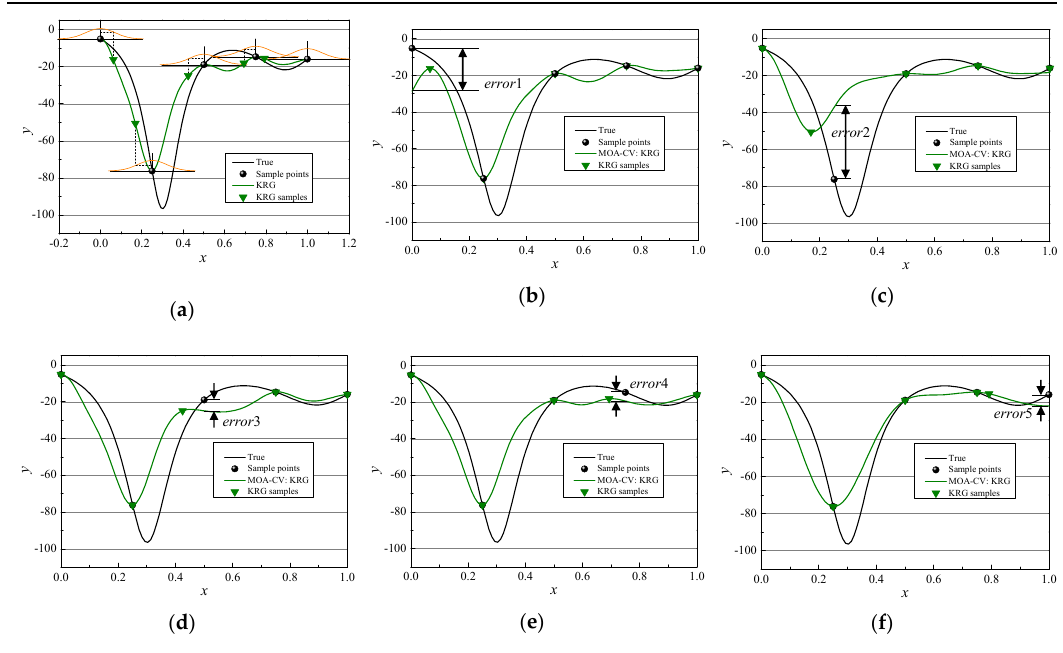
Figure 2. Demonstration of the move-one-away cross validation (MOA-CV) method. ( a ) virtual training points; ( b ) 1st iteration; ( c ) 2nd iteration; ( d ) 3rd iteration; ( e ) 4th iteration; ( f ) 5th iteration. Appl. Sci. 2020 , 10 , x FOR PEER REVIEW